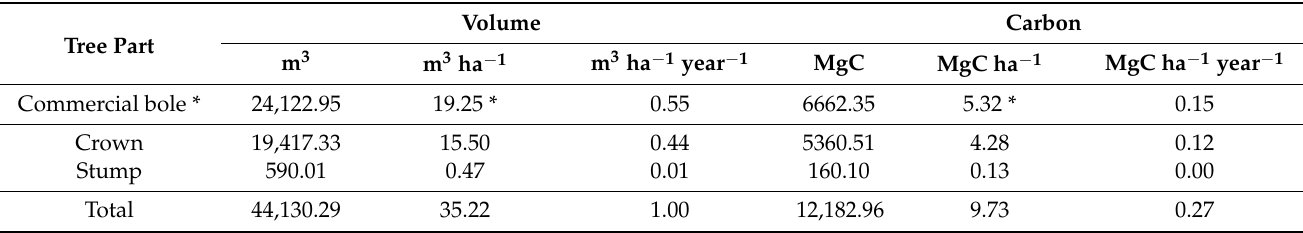
Table 4. Volume and carbon stock in the commercial boles, crowns and stumps of trees of commercial species (DBH ≥ 50 cm) harvested in 1253 ha.